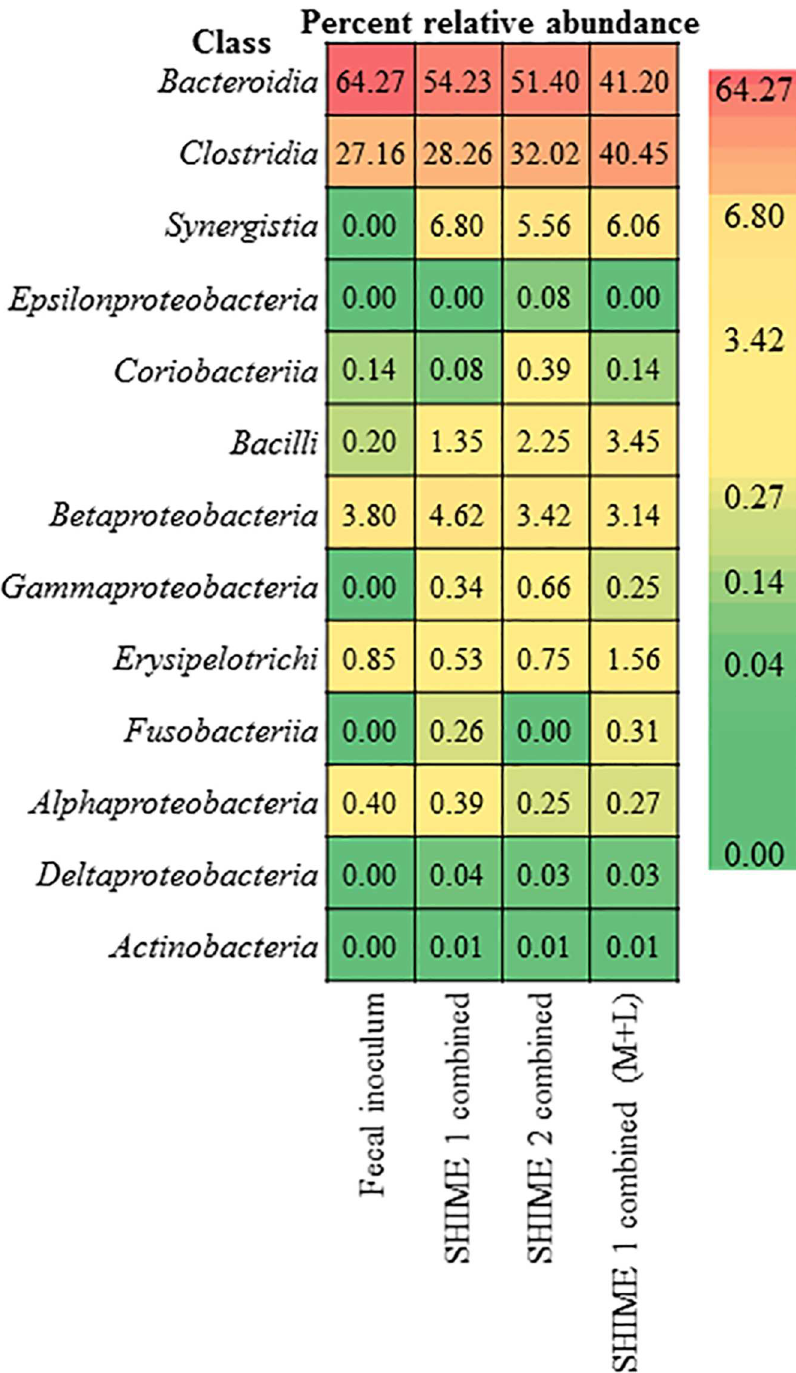
PLOS ONE | https://doi.org/10.1371/journal.pone.0197692 July 17,